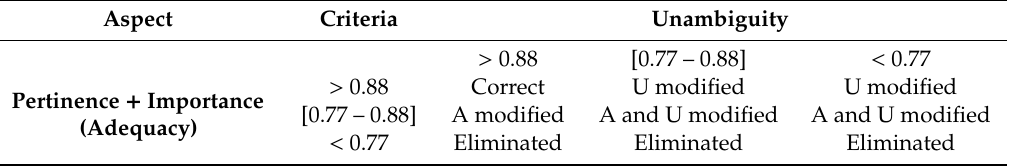
Table 4. Criteria for the elimination, modification or acceptance of the items.